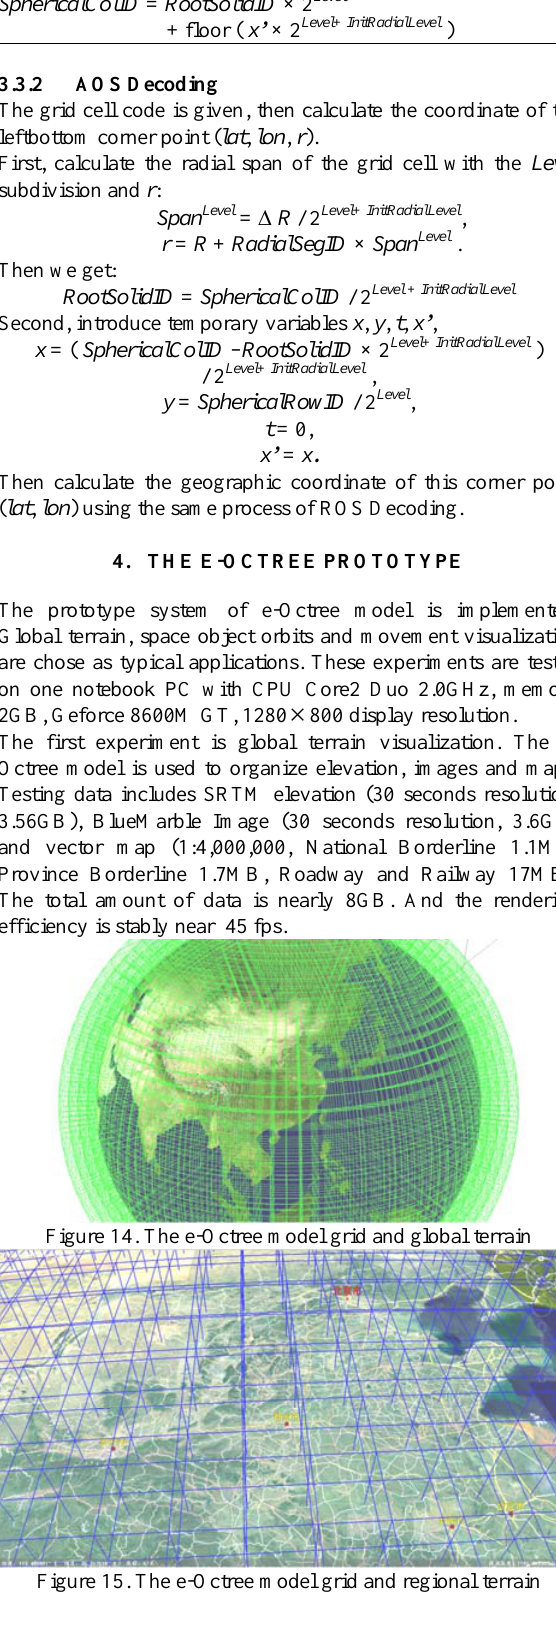
Figure 15. The e-Octree model grid and regional terrain